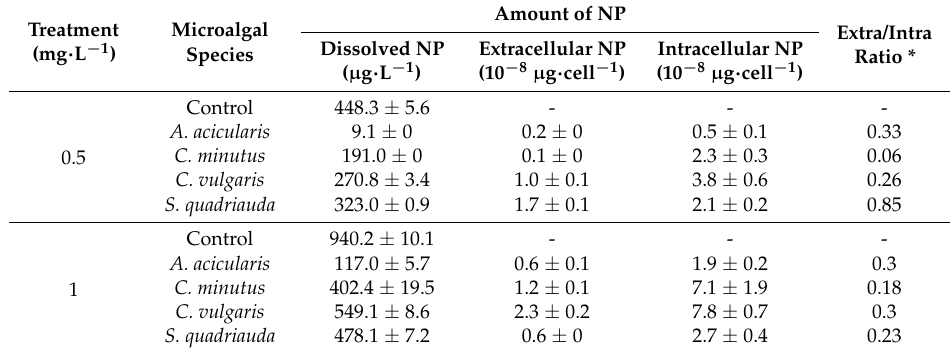
Table 2. Dissolved, intracellular and extracellular NP contents of four freshwater microalgae under different treatments at the end of 72 h. Mean and standard deviation of three replicates are